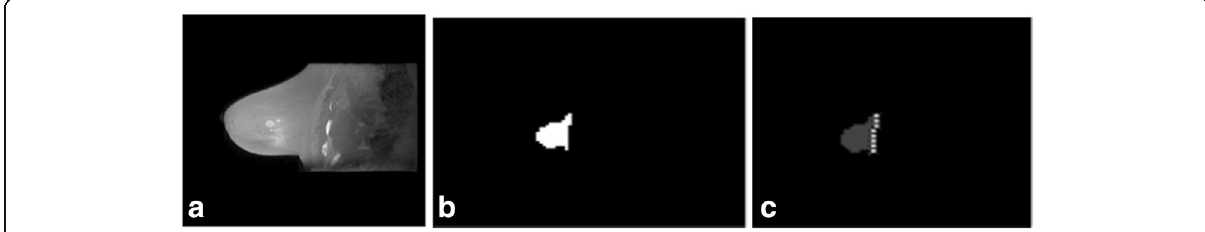
Fig. 3 Segmentation of the nipple and final mask of the nipple-areola complex. a MIP image (maximum intensity projection) performed on T2-weighted image and seed selection. b Segmentation of the nipple (region growing technique) and final mask of the nipple areola complex. c Interpolation of points on nipple